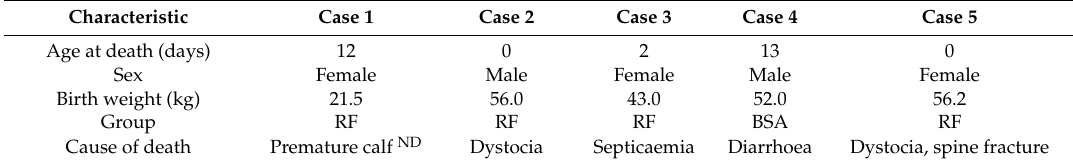
Table 5. Cases of neonatal mortality from calves born by embryo transfer of vitrified-warmed embryos produced with reproductive fluids (RF) or bovine serum albumin (BSA) as supplements to culture